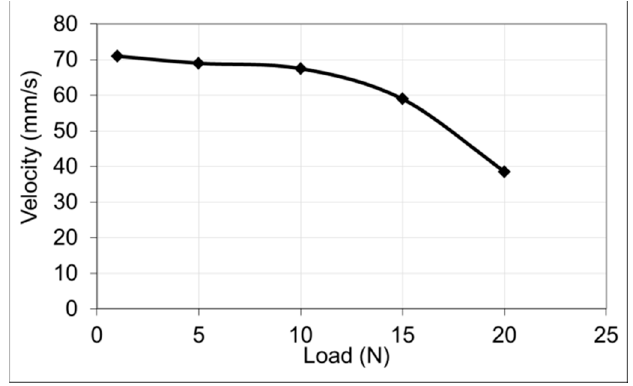
Figure 16. Load characteristics of the test linear motor. Sinusoidal wave signals generating normal and tangential displacements have magnitudes of 160 and 140 V (peak-to-peak), respectively.